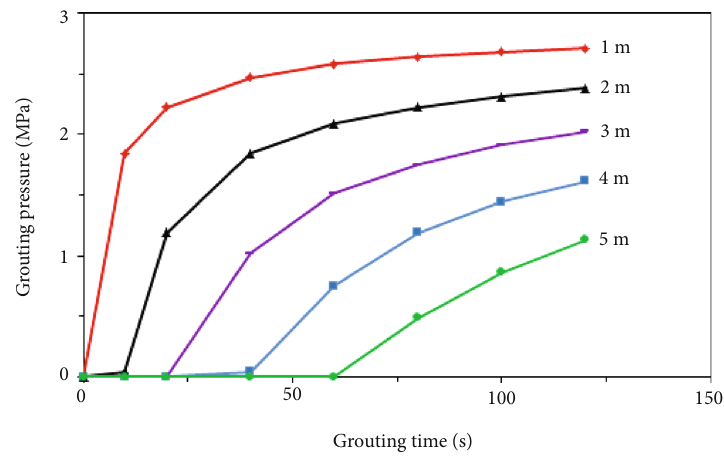
Figure 9: Curves of grouting pressure vs. grouting time.